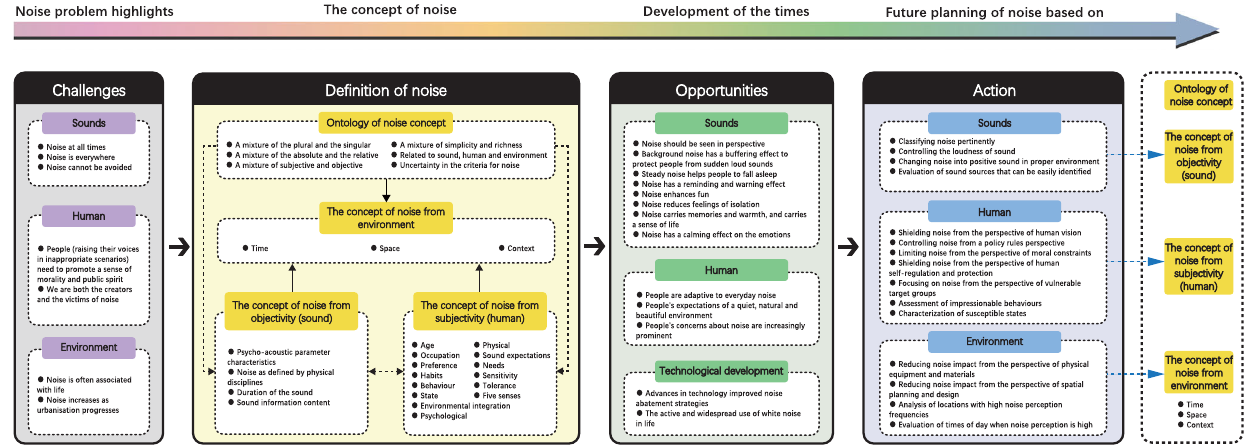
Fig. 6 The structural links between the